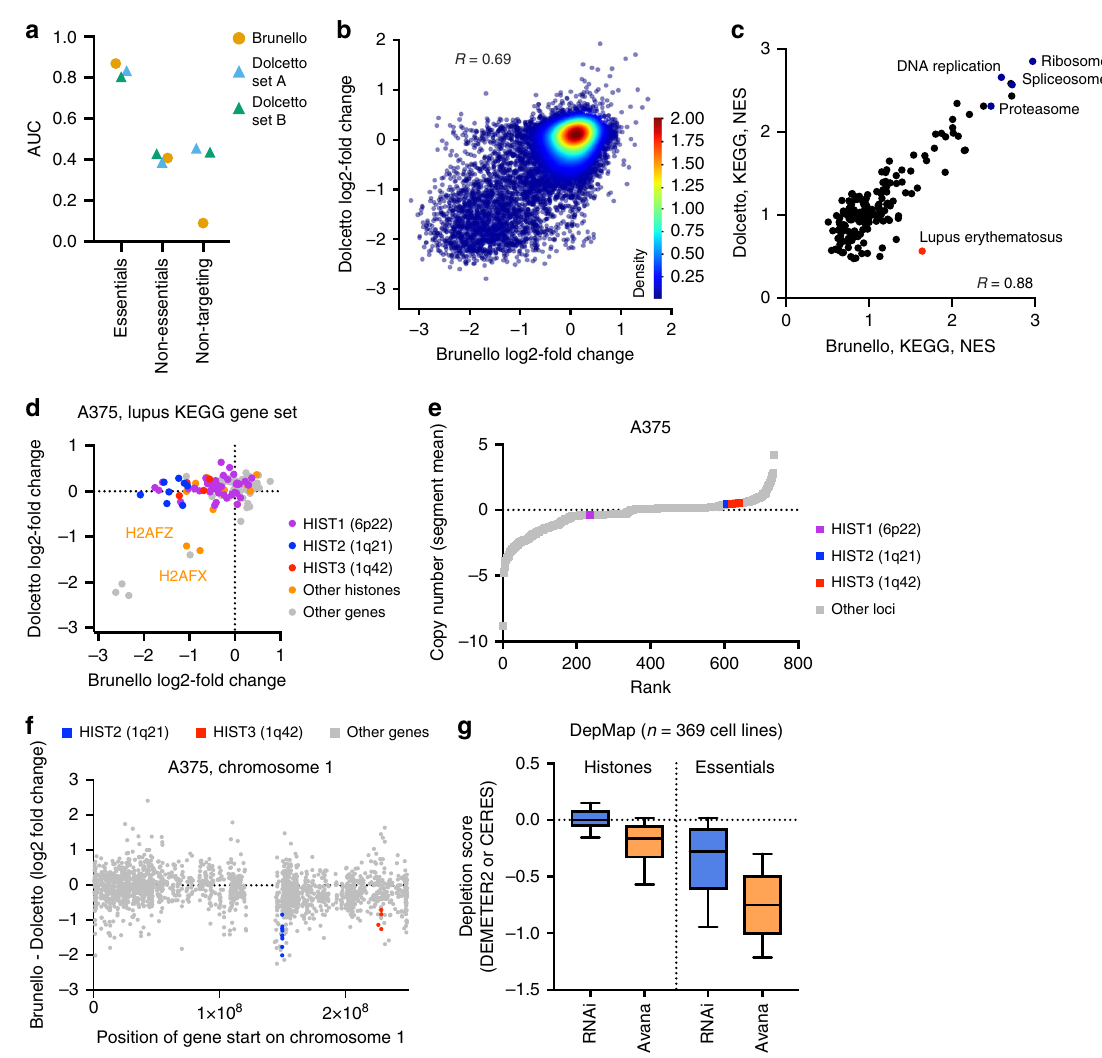
Fig. 4 Comparison of CRISPRko and CRISPRi. a Comparison of AUCs for essential, non-essential and non-targeting sgRNAs across CRISPRko and CRISPRi libraries screened in A375 cells. CRISPRko is plotted as circular points and CRISPRi is plotted as triangles. b Comparison of the log2-fold change of genes in Brunello and Dolcetto (average of Sets A and B). Pearson correlation is reported. c Scatter plot comparing the GSEA normalized enrichment scores (NES) for KEGG genes sets for Brunello and Dolcetto. Selected gene sets are annotated. d Scatter plot comparing log2-fold change of genes from the KEGG Systemic Lupus Erythematosus gene set for Brunello and Dolcetto in A375 cells. Histone genes are colored based on their chromosomal location. e Segmented copy number (segment mean; log2-fold change from average) of genetic loci in A375 cells. f Position of gene start along chromosome 1 compared to the difference in log2-fold change between Brunello and Dolcetto in A375 cells. g Depletion of histone genes and essential genes in data from the Project Achilles screens in 369 cell lines screened with both RNAi and CRISPR (Avana library). The box represents the 25th, 50th, and 75th percentiles; whiskers show 10th and 90th